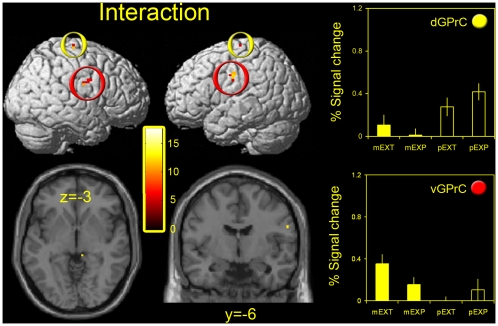
Whole brain analyses – interaction between response mode and target type.Left and central panel: group level activations are shown for the interaction between response mode and target type (P<0.001 uncorrected) rendered on a T1-weighted structural image in stereotactic space (upper panels) or selected axial and coronal slices (lower panels). In addition, estimates of BOLD signal changes (relative to rest) from the GLM analysis are shown for the 4 experimental conditions (mEXT, mEXP, pEXT, pEXP) for the main clusters of activity (right panel). Error bars represent one standard error of the mean. As in Figure 3 the colored patches in the upper right corner of the graphs are color coded to match the colored rings denoting defined loci in the brain slices and whole brain projections. dGPrC – dorsal pre-central gyrus (yellow rings); vGPrC – ventral pre-central gyrus (red rings).